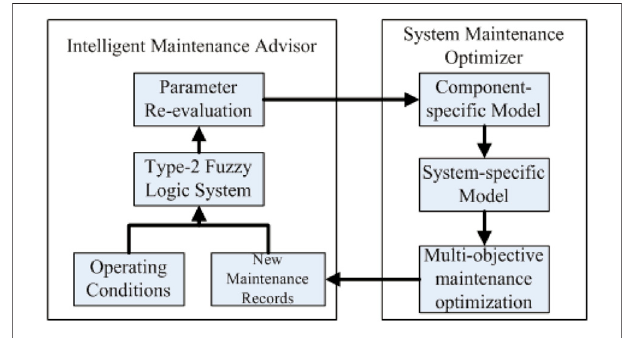
FIGURE 1 | Adaptive condition-based maintenance scheme for the offshore substation.